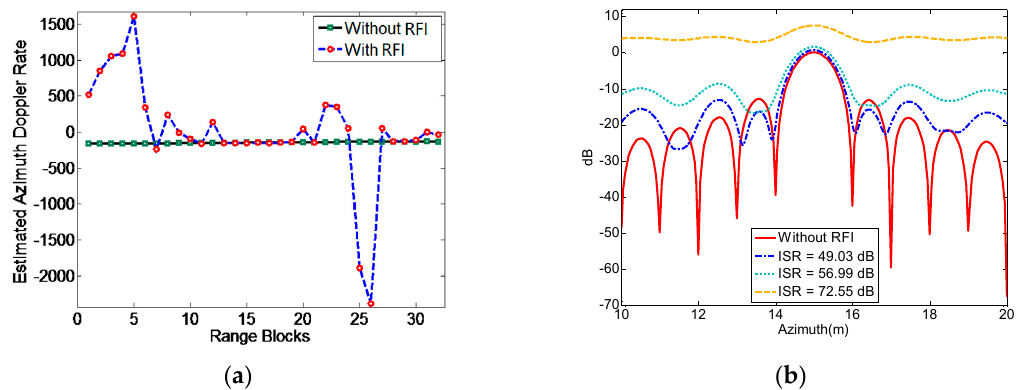
Figure 3. The e ff ects of RFI on image formation process. ( a ) Variation of the estimated azimuth Doppler rate with range blocks in the case with and without interference a ff ection. (Courtesy of Tao et al. [8]) ( b ) Sectional drawings of the point target response after matched filtering using biased parameters under di ff erent interference to signal ratio (ISR). (Courtesy of Tao et al. [ Error! Reference source not found. ]).